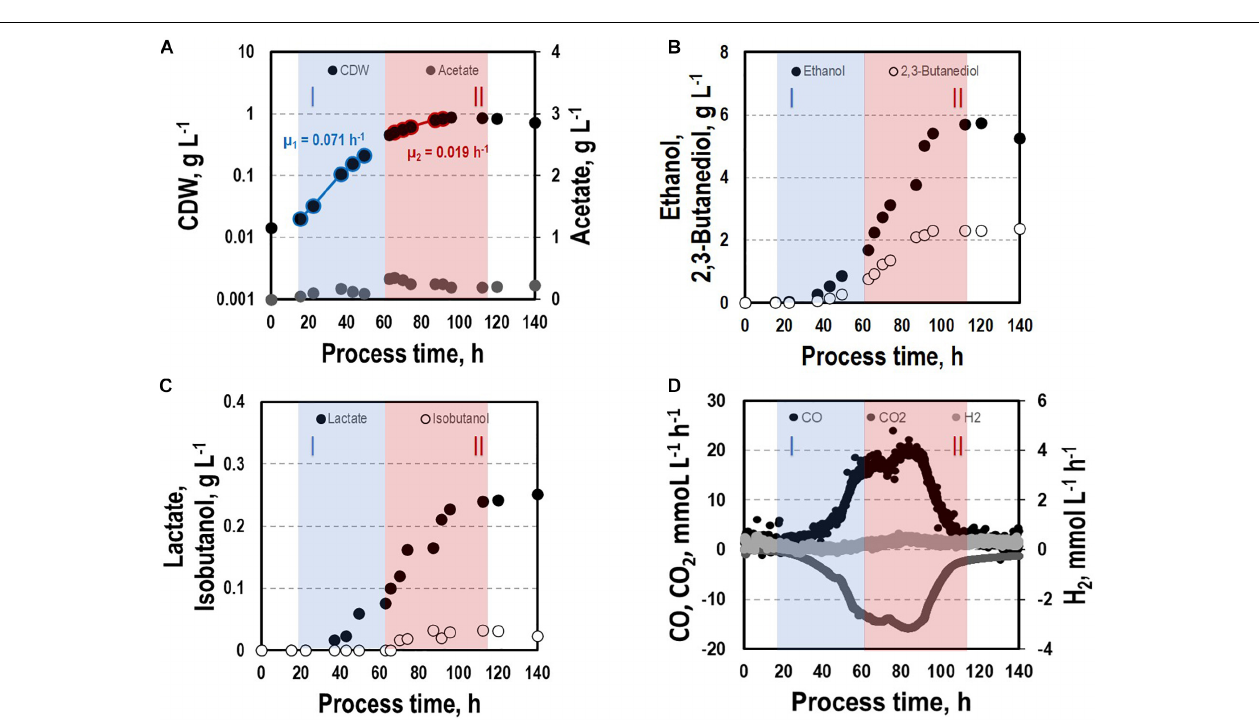
FIGURE 6 | Syngas-based batch cultivation of CLJU[KAIA] in a stirred tank bioreactor with a continuous gas supply. Shown are the concentrations of cell dry weight and acetate (A) , ethanol and 2,3-butanediol (B) , lactate and isobutanol (C) , and the gas uptake (D) ( T = 37 ◦ C; pH = 5.9; VR = 3 L; 500 rpm). Two growth phases I (marked blue) and II (marked red) were identified. Statistical details are given in the Supplementary Material ( Supplementary Table 1 )